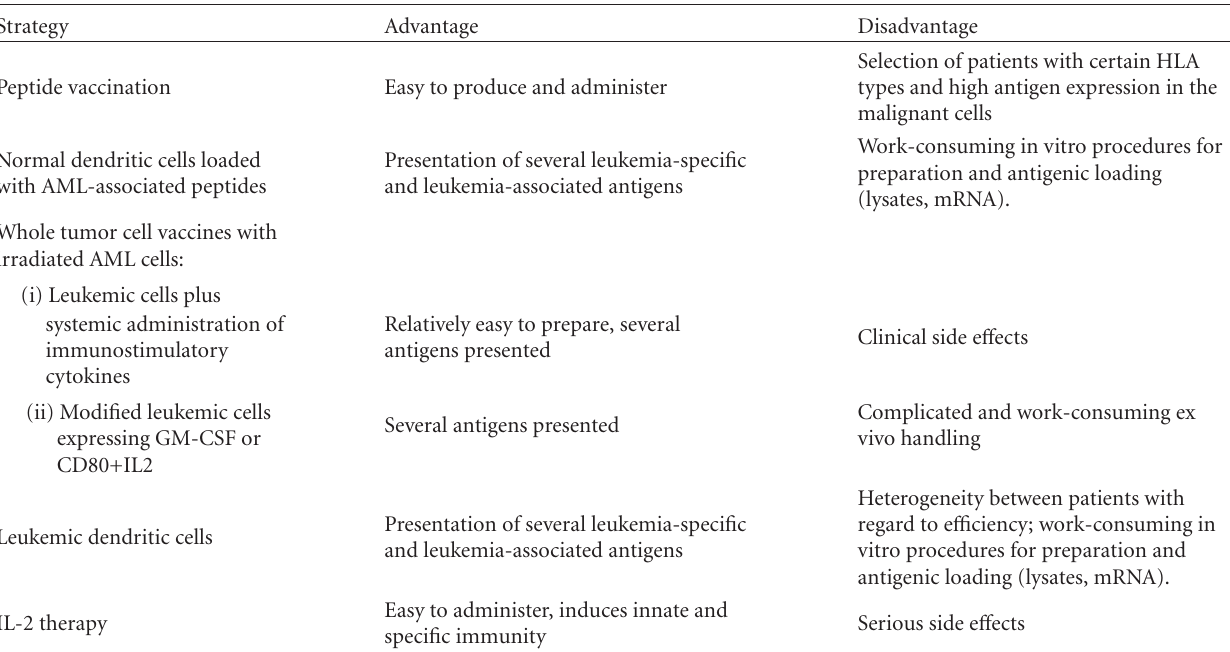
Table 3: Immunotherapy in AML; the advantages and disadvantages of the various approaches that have been investigated in clinical trials [82]. Strategy Advantage Disadvantage Peptide vaccination Easy to produce and administer Normal dendritic cells loaded Presentation of several leukemia-specific with AML-associated peptides and leukemia-associated antigens